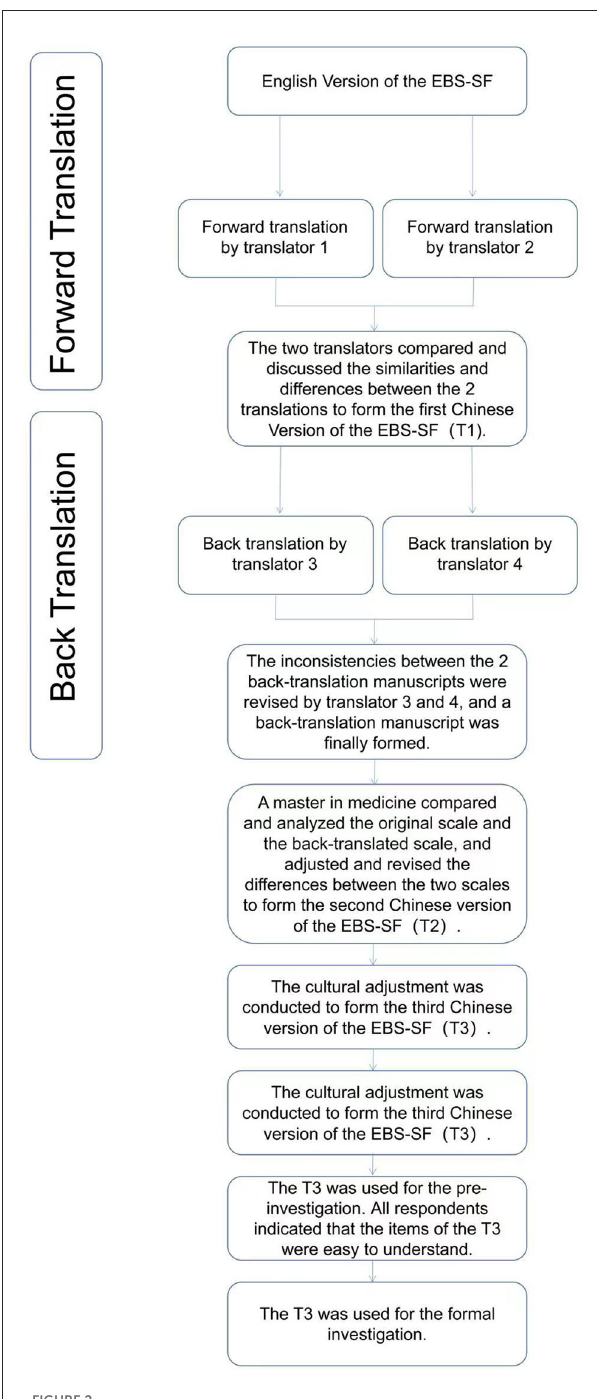
FIGURE2 The process of the EBS-SF scale translation